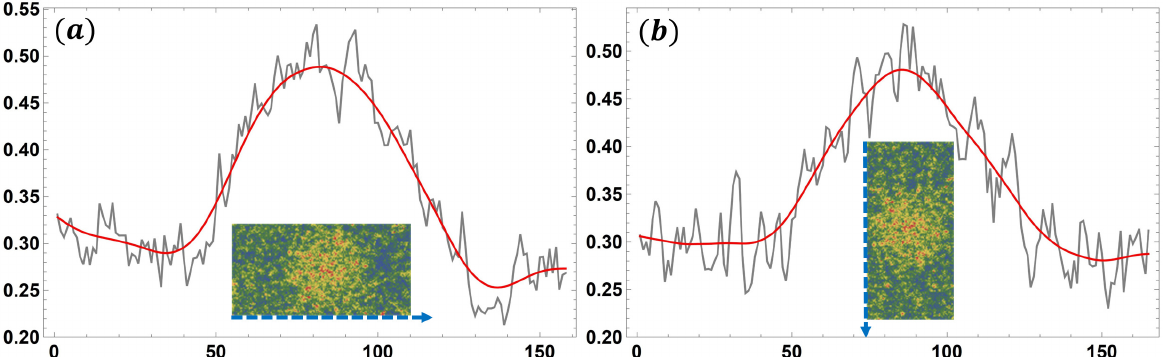
Figure 19. Neighborhood analysis for the reference spherical void, transmission along the shorter axis: normalized width mean of luminance (gray) over the length of ( a ) horizontal and ( b ) vertical patches roughly fit to the sphere dimensions, spanning the cropped body images. Note the pixel-to-mm scale bar in ( a ). Patch scan directions are indicated by the dashed blue arrows. The image patches are not to scale and their luminance maps are normalized as in Figure 18. The red curve is the total variation filtered (Gaussian, regularization parameter equal to 1 [58]) gray curve.